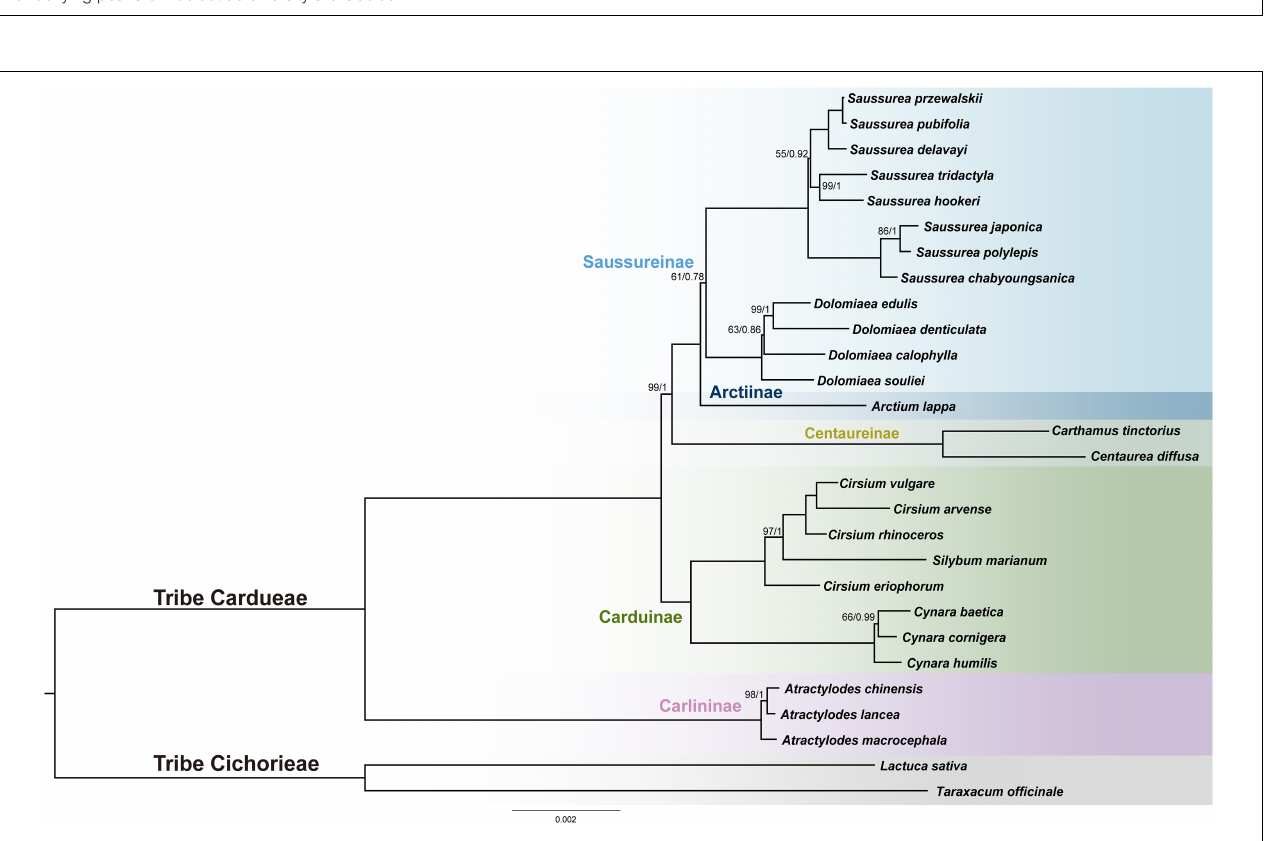
FIGURE 5 | Sliding window analysis of nucleotide diversity ( π ) along the whole plastome for the 26 aligned plastomes of Cardueae with one IR copy included. Genes underlying peaks of nucleotide diversity are labeled.